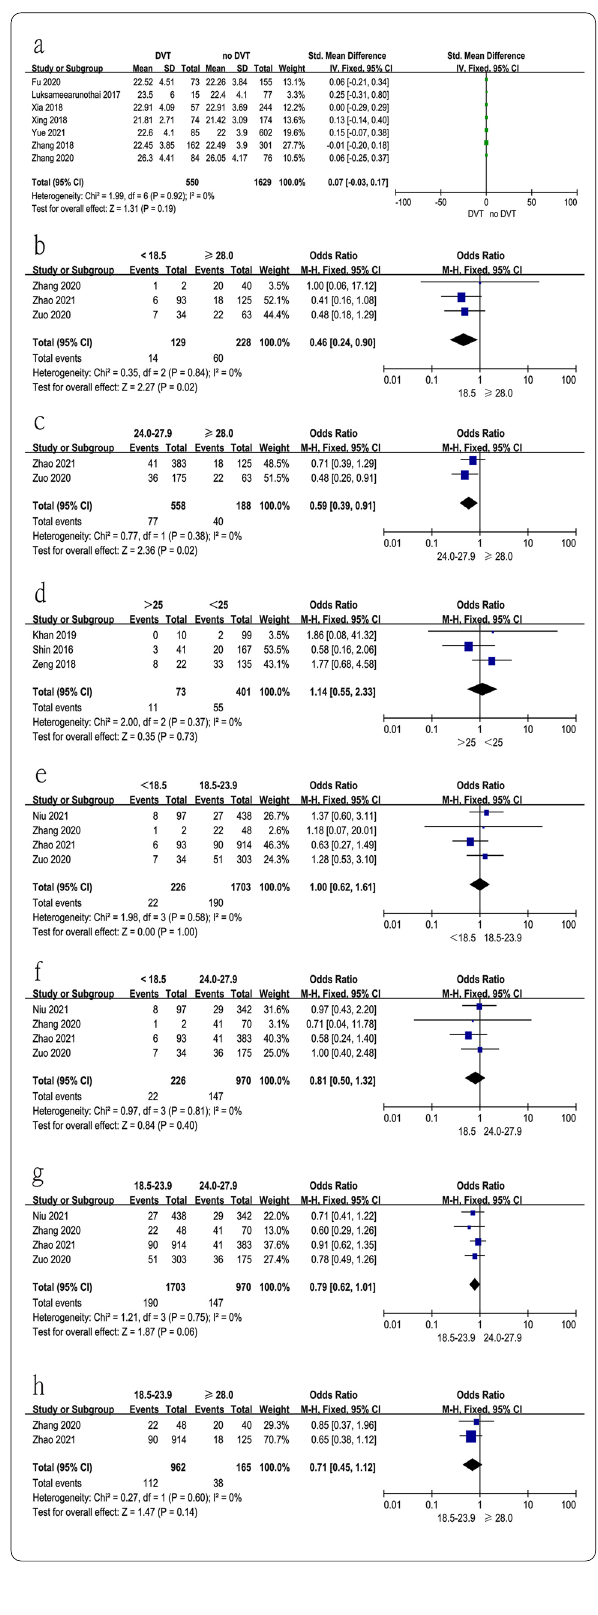
Fig. 4 Forest plot showing body mass index in 2 groups. CI confidence interval, df degrees of freedom, M-H Mantel–Haenszel. a Relationship between BMI at surgical time and preoperative DVT; b < 18.5 kg/m 2 vs > 28 kg/m 2 ; c 24.0–27.9 kg/m 2 vs > 28 kg/ m 2 ; d < 25 kg/m 2 vs > 25 kg/m 2 ; e < 18.5 kg/m 2 vs 18.5–23.9 kg/m 2 ; f < 18.5 kg/m 2 vs 24.0–27.9; g 18.5–23.9 kg/m 2 vs 24.0–27.9 kg/m 2 ; h 18.5–23.9 kg/m 2 vs > 28 kg/m